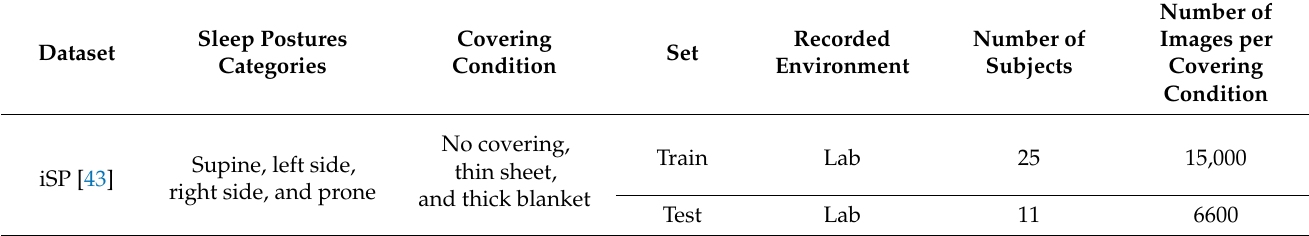
Table 5. The iSP real-life dataset summary.